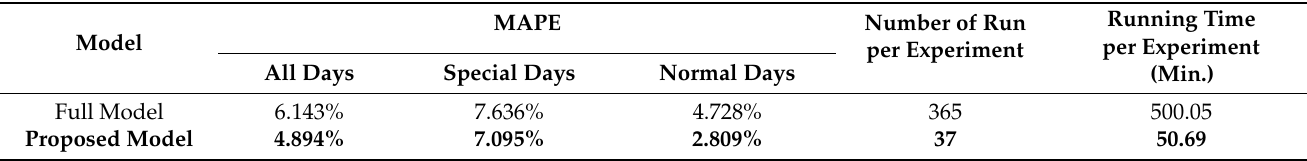
Table 15. Additional experiment for comparing the full model and the proposed